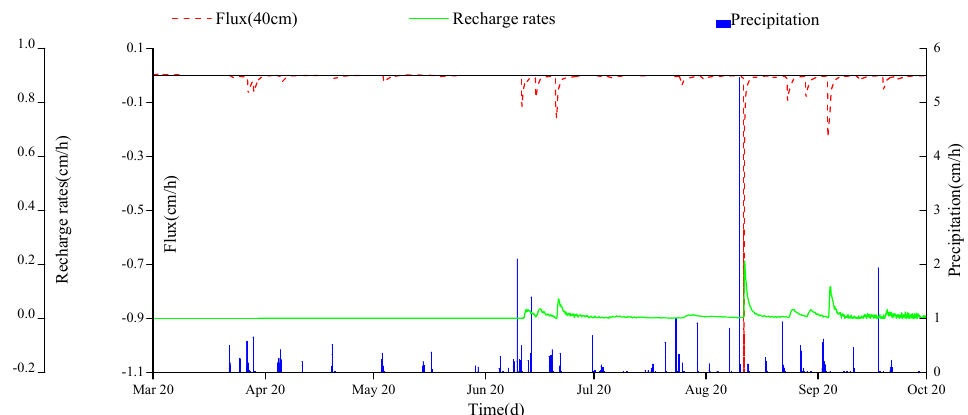
Figure 10. Modeled recharge rates and fluxes with different precipitations. It describes the precipitation, soil fluxes, and groundwater recharge rates time-series during the research period.